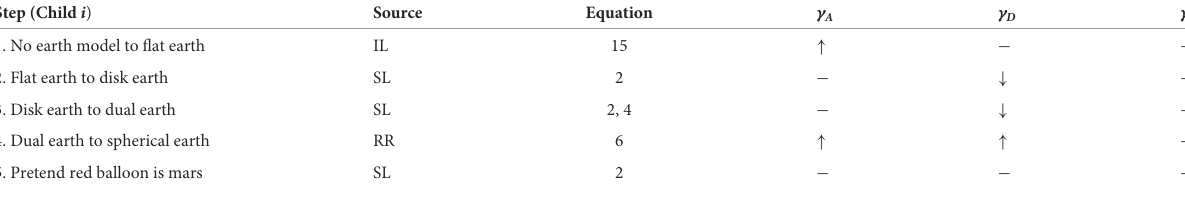
TABLE 5 Conceptual change in child i , and source of change, i.e., whether a given transition was due to individual learning (IL), social learning (SL), or representational redescription (RR), resulting in a new mental